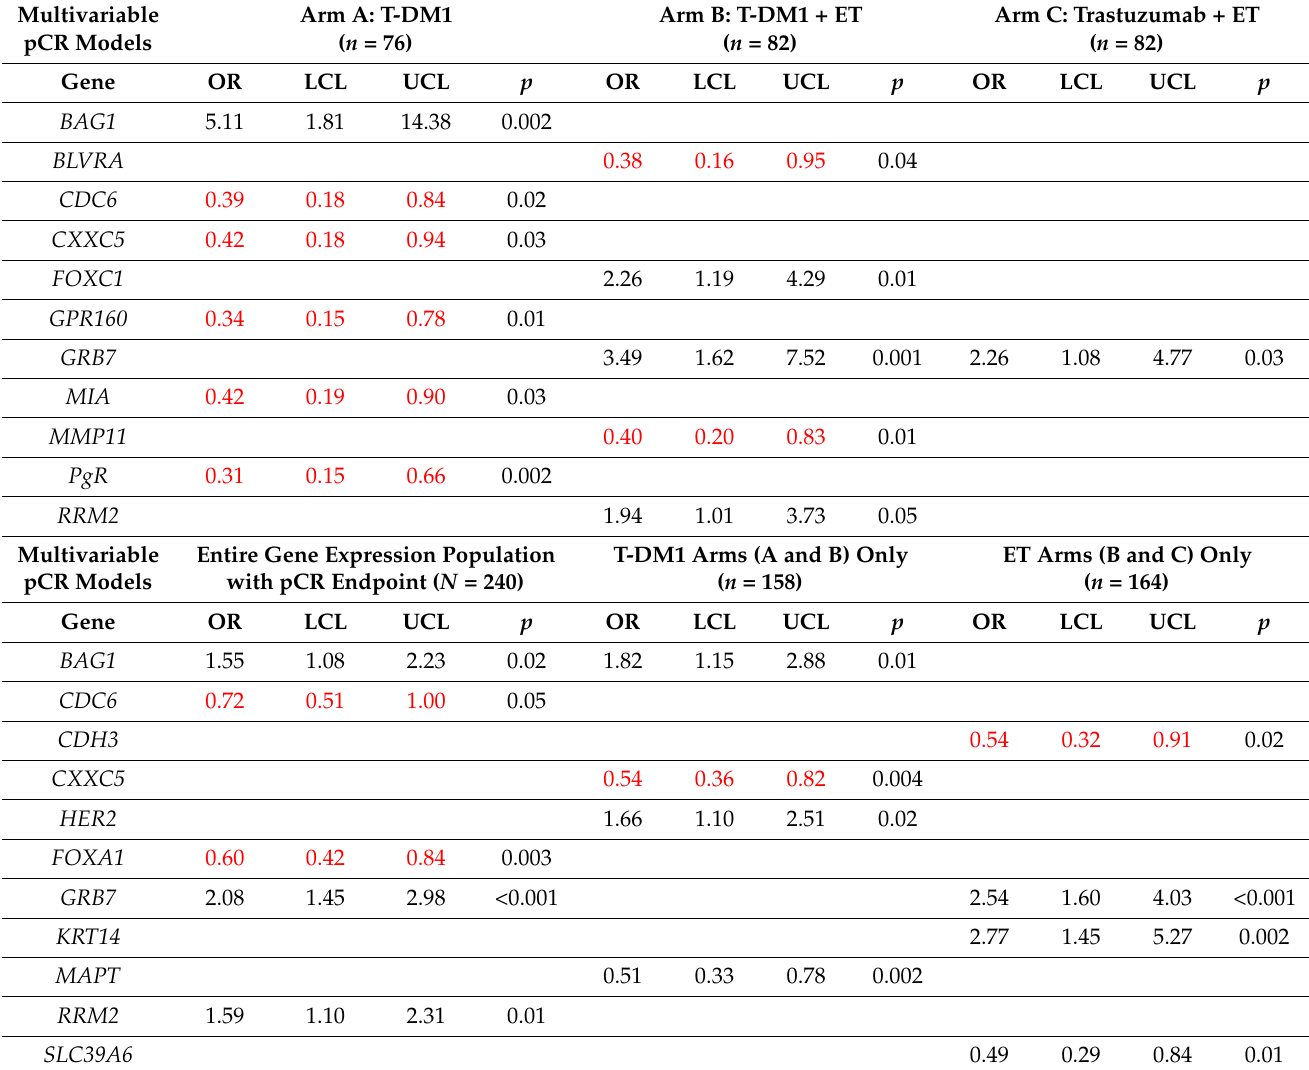
Table 4. Adjusted standardized ORs of genes with significant impact on pCR in multivariable logistic regression models. All 53 gene expression levels and PAM50 subtypes were entered. ORs ≤ 1 are shown in red; ORs > 1 are shown in black.